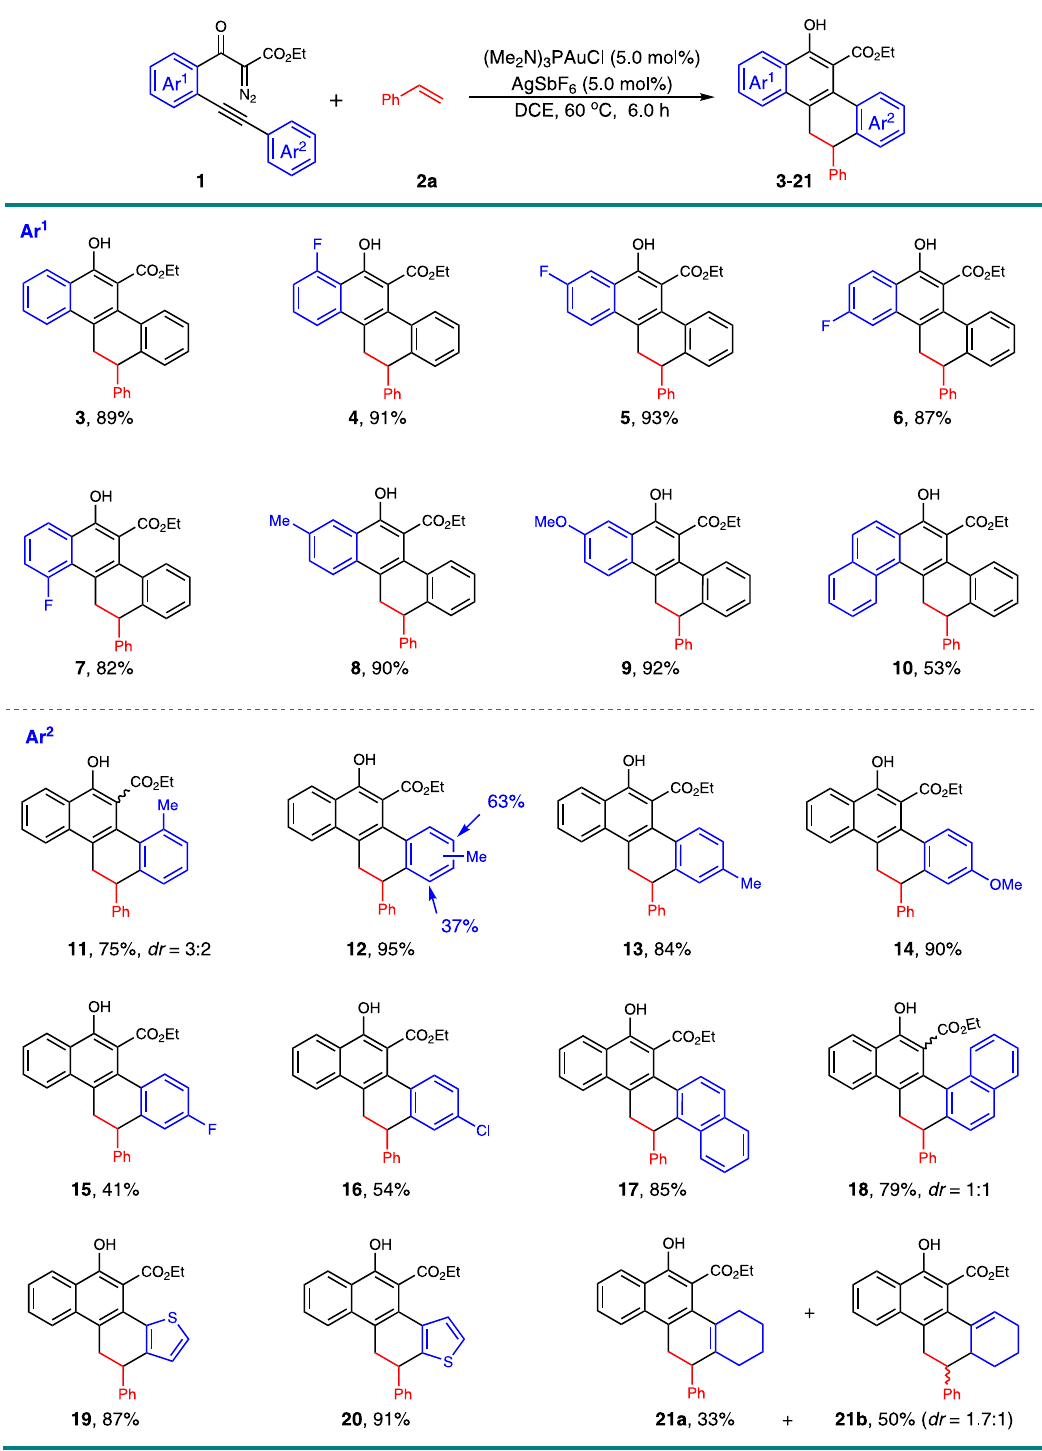
Fig. 2 Scope with respect to the diazo compounds 1. Reaction conditions: to a solution of (Me 2 N) 3 PAuCl (3.95 mg, 0.01 mmol), and AgSbF 6 (3.4 mg, 0.01 mmol) in DCE (0.5 mL), we added a solution of 1 (0.2 mmol) and styrene 2a (31.2 mg, 0.3 mmol) in DCE (0.5 mL) at 60 °C, then the reaction mixture was stirred for 6 h under these conditions. Isolated yields are